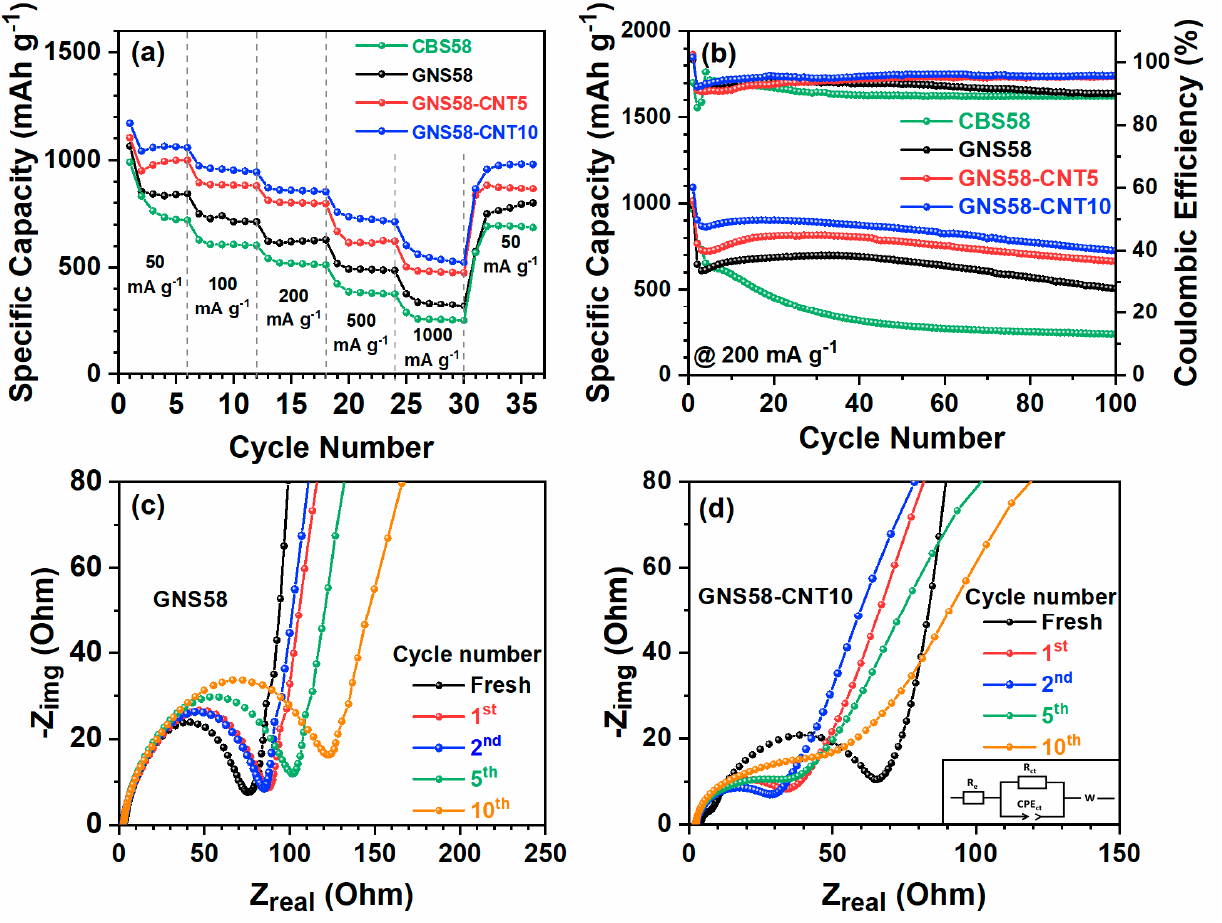
Figure 4. ( a ) Galvanostatic rate performance, and ( b ) cycling performance of GNS58, GNS58-CNT5 and GNS58-CNT10 cathodes. Nyquist plot of ( c ) GNS58 and ( d ) GNS58-CNT10 cathodes. Inset: equivalent circuit model used for fitting the EIS spectra.